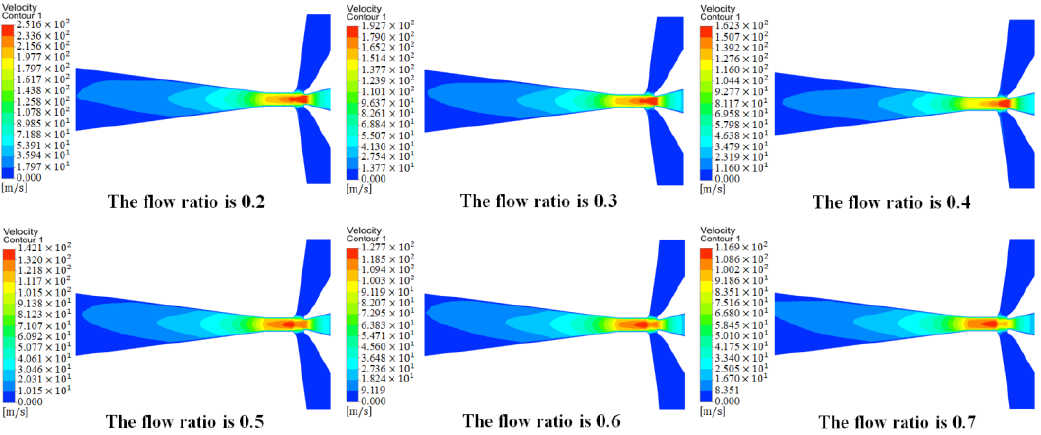
Figure 10. Velocity cloud diagrams of the flow field in the new jet pump with different flow ratios.